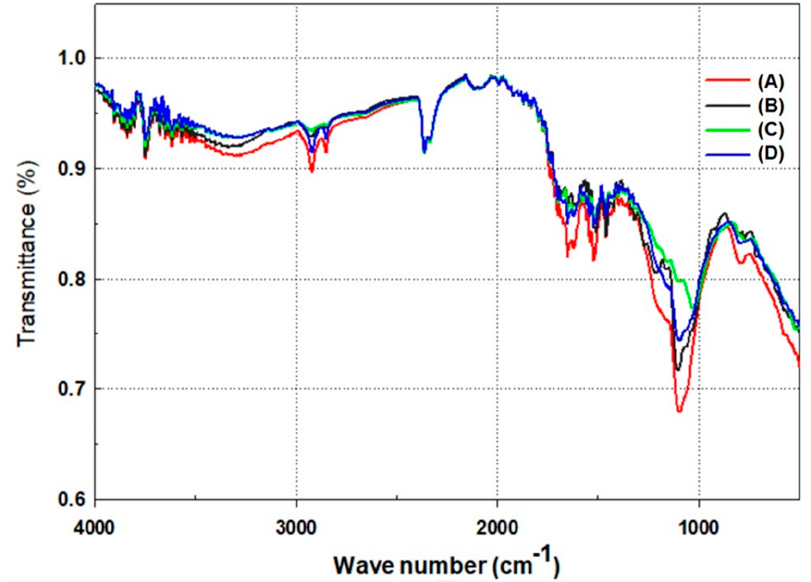
Figure 3. The Fourier transform infrared (FTIR) spectra of ( A ) leaflet (L), ( B ) rachis (R), ( C ) fibers (F), and ( D ) composite (M) samples.